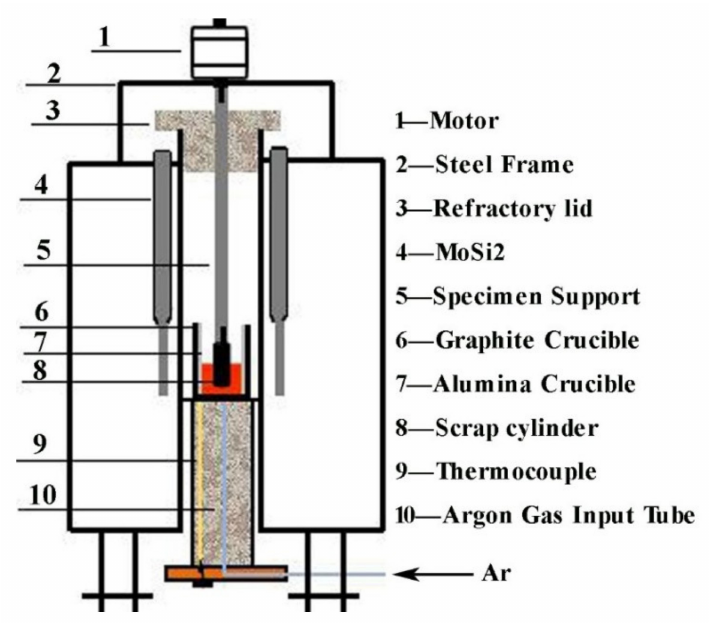
Figure 1. Schematic of experimental